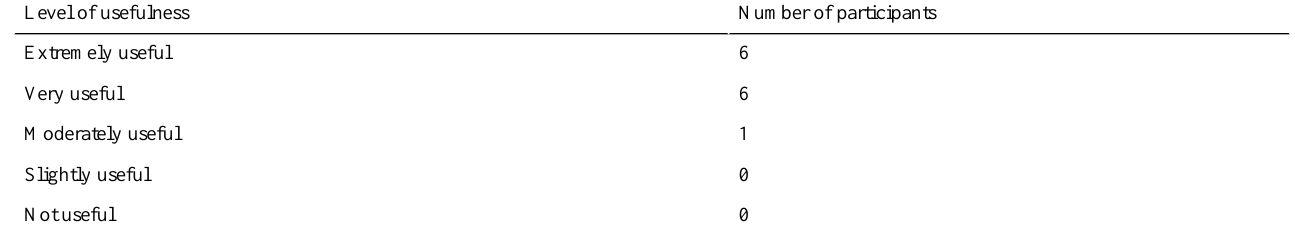
Table 6. Reported usefulness level.